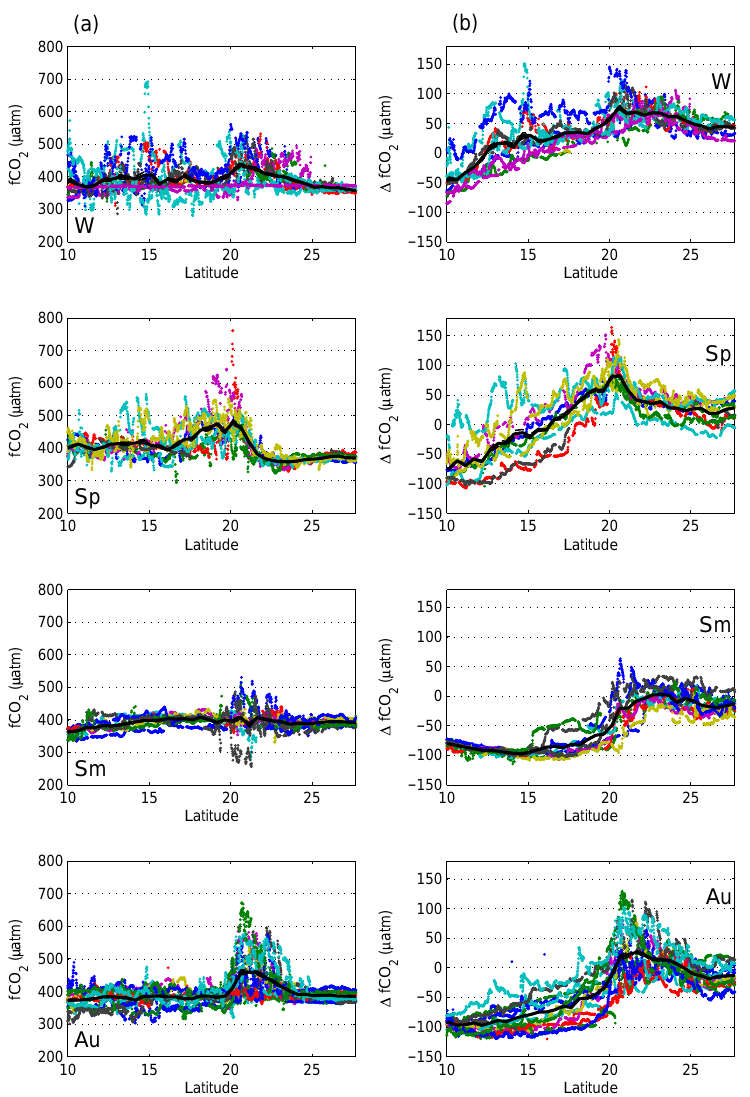
Figure 5. Fugacity of CO 2 data in the Mauritanian–Cap Vert coastal region grouped by seasons: winter (W; December, January, and Febru- ary), spring (Sp; March, April, and May), summer (Sm; June, July, and August), and autumn (Au; September, October, and November). Column (a) f CO sw latitudinal distribution. Column (b) , difference between measured and f CO sw 2 ature of 22 ◦ C. The averaged values for all cruises in Table S1 are shown in black for each season including the 95% confidence limits. The color code for each cruise is indicated in Table